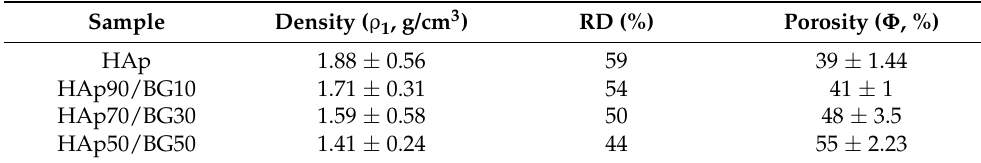
Table 3. Addition of BG in the HAp/BG composite with the density, relative density (RD), and porosity percentage (the results were expressed as mean ± SD, n = 5).